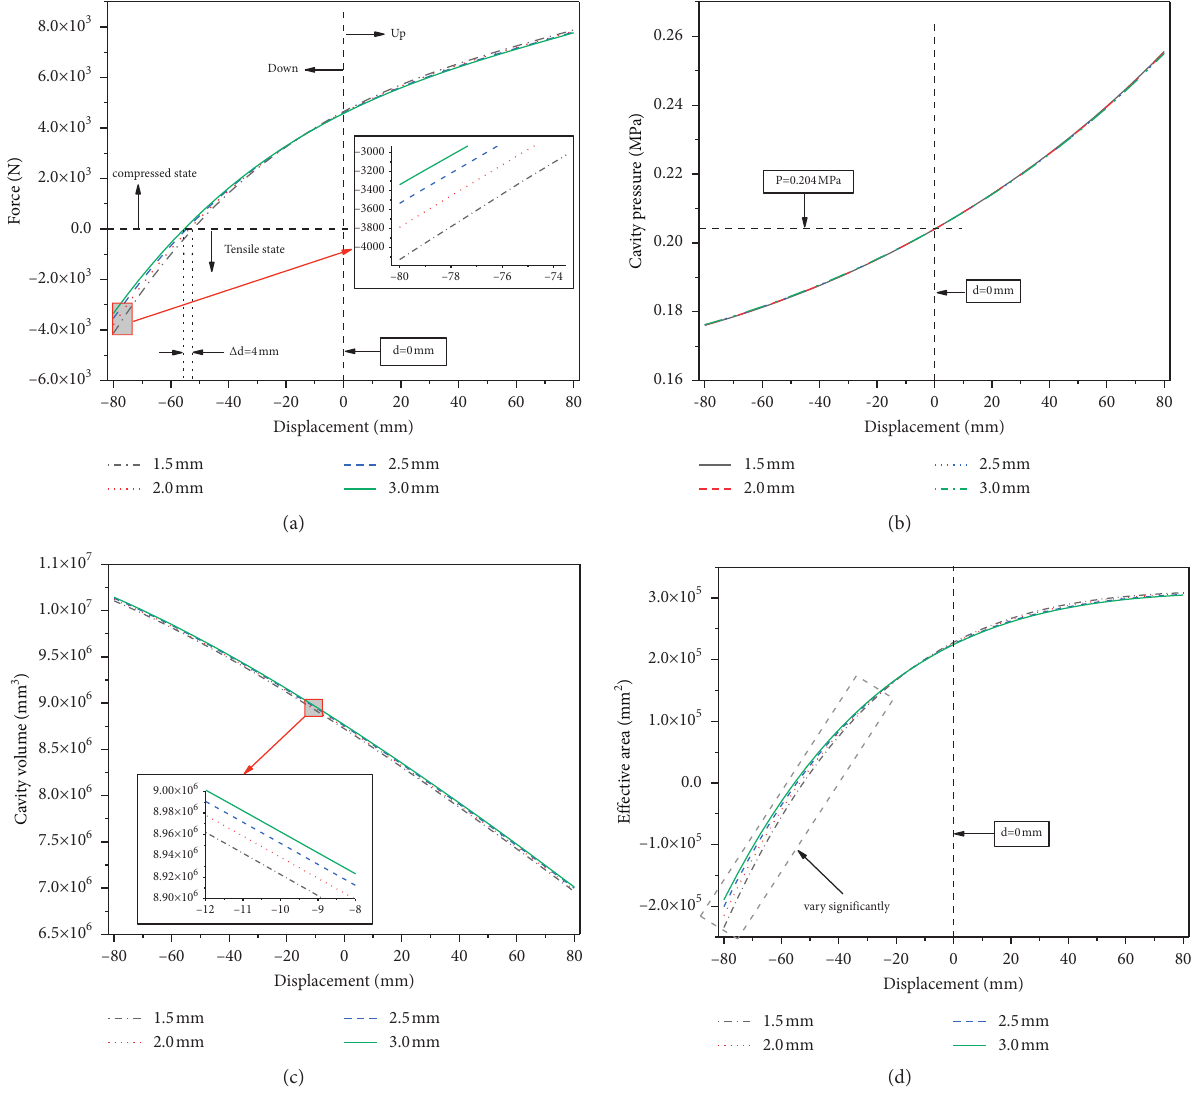
Figure 11: Effect of cord layer spacing on airbags: (a) for load, (b) for pressure, (c) for volume, and (d) for effective